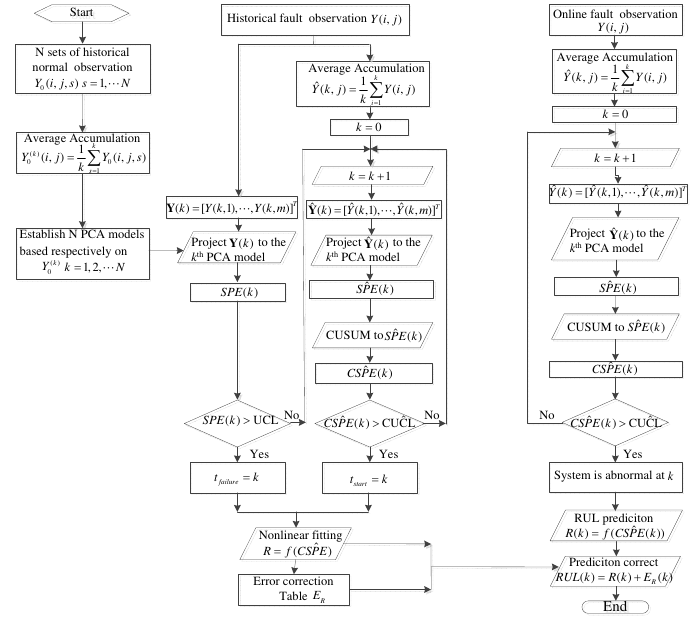
Figure 2. Flowchart of CUSUM-AA-PCA based fault